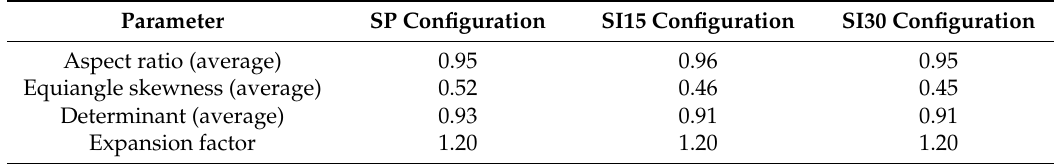
Figure 3. The overview of the mesh used at the steady domain ( a ) and the surface mesh on the turbine blades and hub ( b ). Table 1. The parameters describing the quality of the mesh for the different turbine configurations.